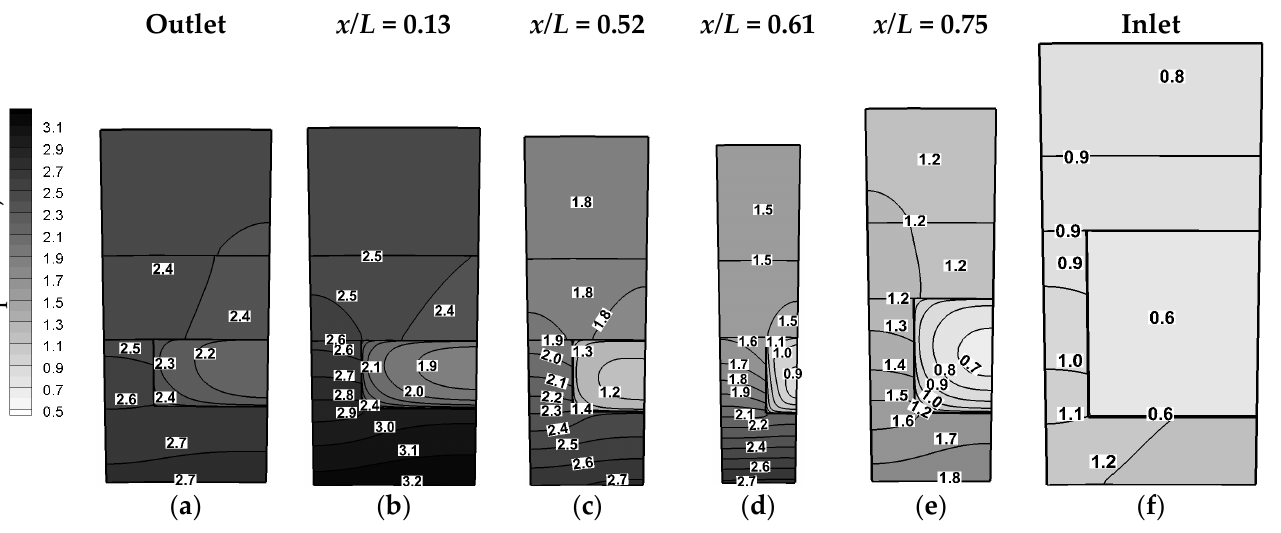
Figure 15. Nominal operating point: dimensionless temperature distribution, including some transversal slices.